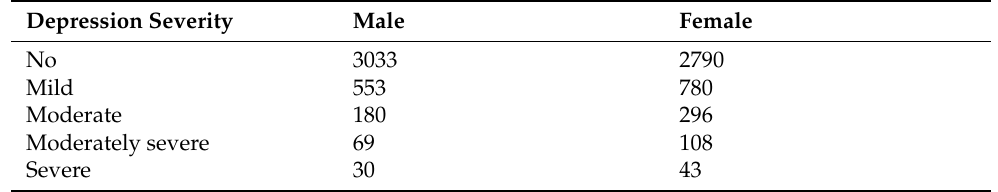
Table 5. Depression severity by